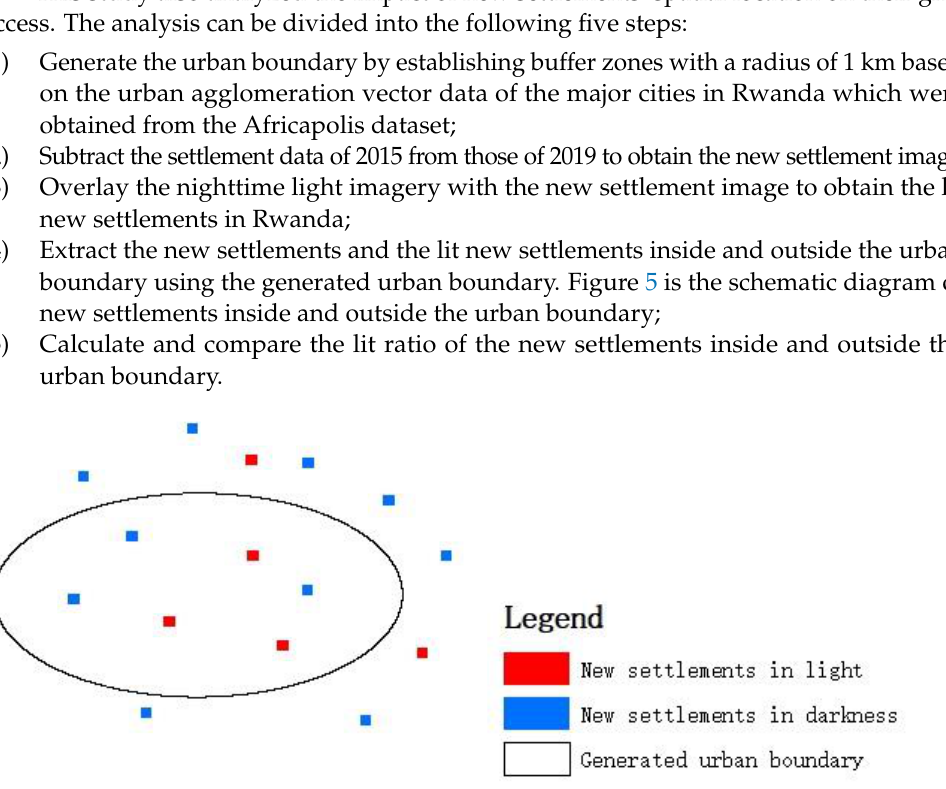
Figure 5. The schematic diagram of new settlements inside and outside the urban boundary. The red areas show the new settlements with positive nighttime light radiance, while the blue areas show the new settlements in darkness.